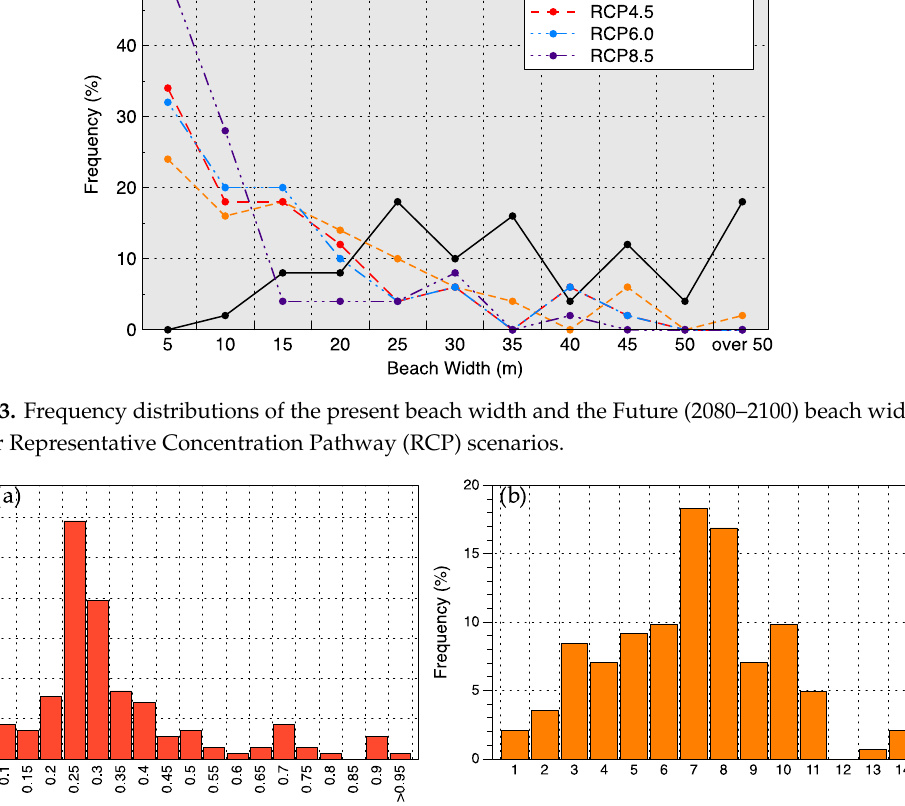
Figure 4. Beach characteristics by field measurement over 230 locations for all beach zones. ( a ) The average sediment size was collected at the foreshore of the beach and the size was measured through standard sieve analysis. ( b ) The average beach slope measured by an angle meter at the foreshore of each sandy beach. The figure was reproduced from Ritphring et al. [10].